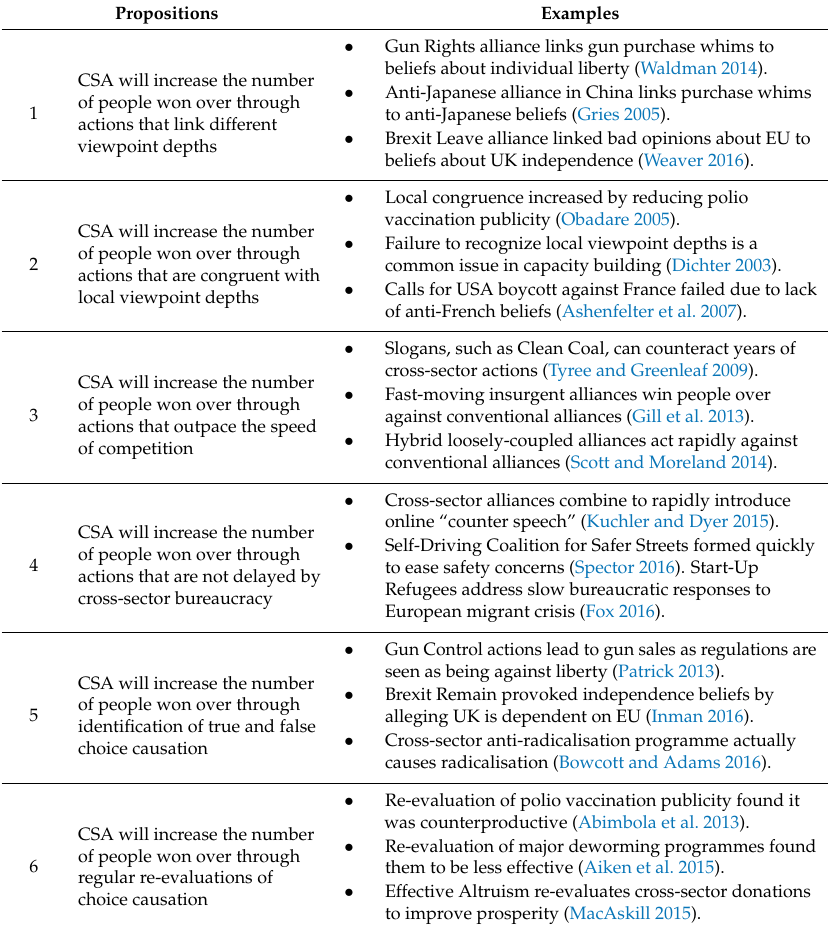
Table 2. Summary of